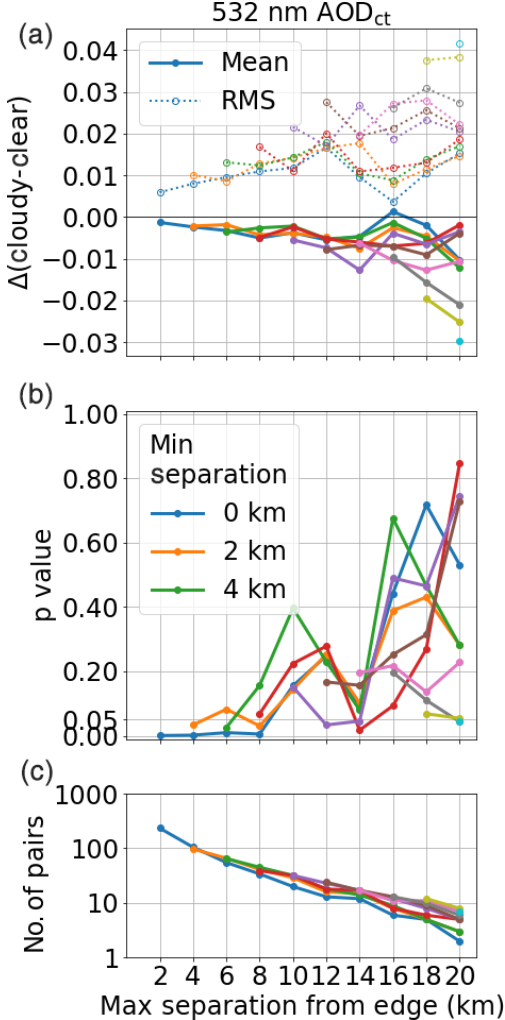
Figure 6. (a) The mean and root-mean-square deviations of the AOD above cloud top between the cloudy and clear sides of cloud edges. Each side is defined by the horizontal separation from cloud edge. The maximum separation (e.g., 12km in Fig. 3) is indicated on the x axis. Each line represents the minimum temporal separa- tion (e.g., 4km in Fig. 3) of 0, 2, 4, ..., 18km in descending order of line length. (b) The p values determined through the paired t